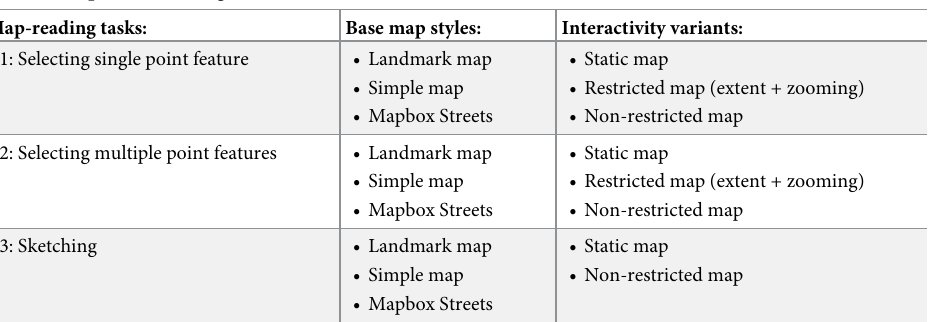
Table 2. Map variation